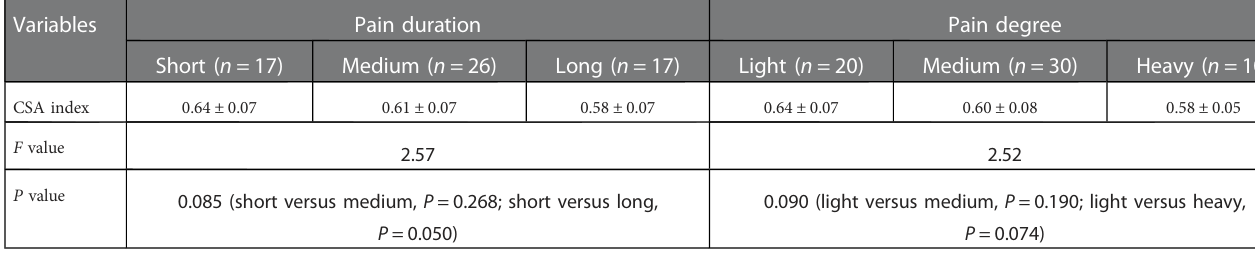
TABLE 4 Comparison of the maximum CSA indices of PM of three subgroups in the LLP group.